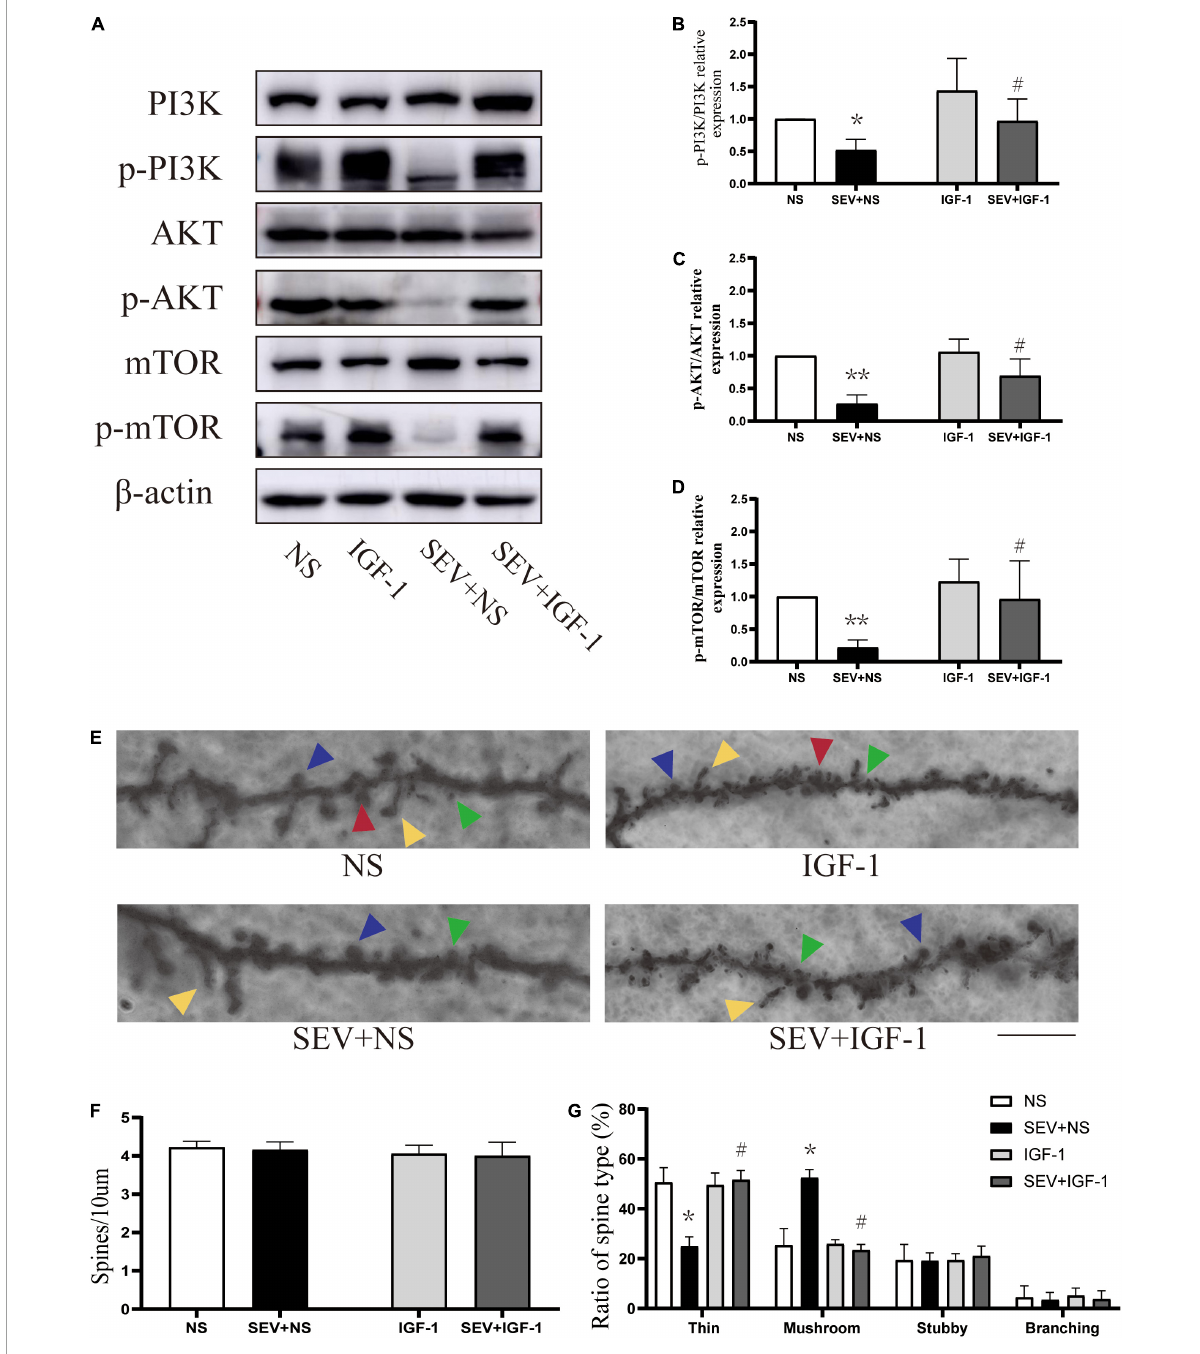
FIGURE4 IGF-1 can alleviate the inhibition of PI3K/AKT/mTOR phosphorylation and rescue sevoflurane-induced morphological abnormality of dendritic spines. (A) Representative Western blot of PI3K, AKT, mTOR, and phosphor-PI3K, phosphor-AKT, phosphor-mTOR for different groups. β -actin was used as reference. (B–D) Bars represent normalization of target proteins were ratios of phosphorylated and non-phosphorylated forms. Results of one-way ANOVA and significance are shown inside graphs: data were presented as mean ± SD, n = 6 for per group. (E) Representative images of Golgi staining of dendritic spines in the hippocampi of PND 14 mice for different groups. Different spine types are indicated by relevant color arrowheads: thin spine (yellow), mushroom spine (blue), stubby spine (green), branching spine (red). Scale bar = 10 µ m. (F) The density of the dendritic spines in different groups. (G) The proportions of dendritic spine types in different groups. Data were presented as mean ± SD by one-way ANOVA, n = 6 mice per group. * P < 0.05, ** P < 0.01 vs. NS; # P < 0.05 vs. SEV +